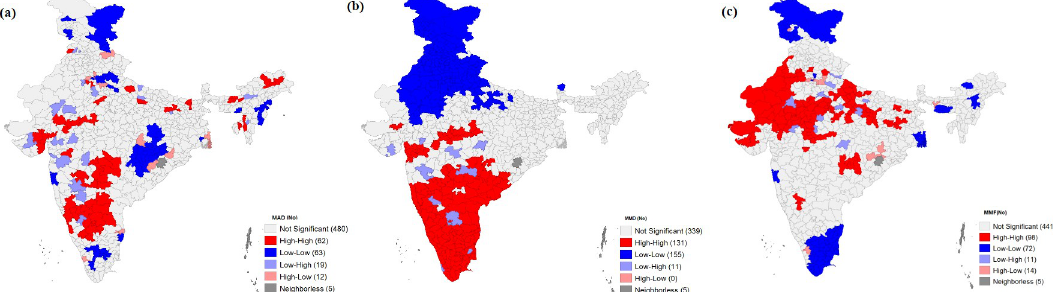
Fig 4. Map showing the clustering of districts for MAD, MDD and MMF among children aged 6–23 months, India, 2015–16.